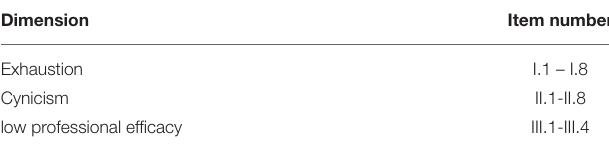
TABLE A2 | Trainer’s burnout